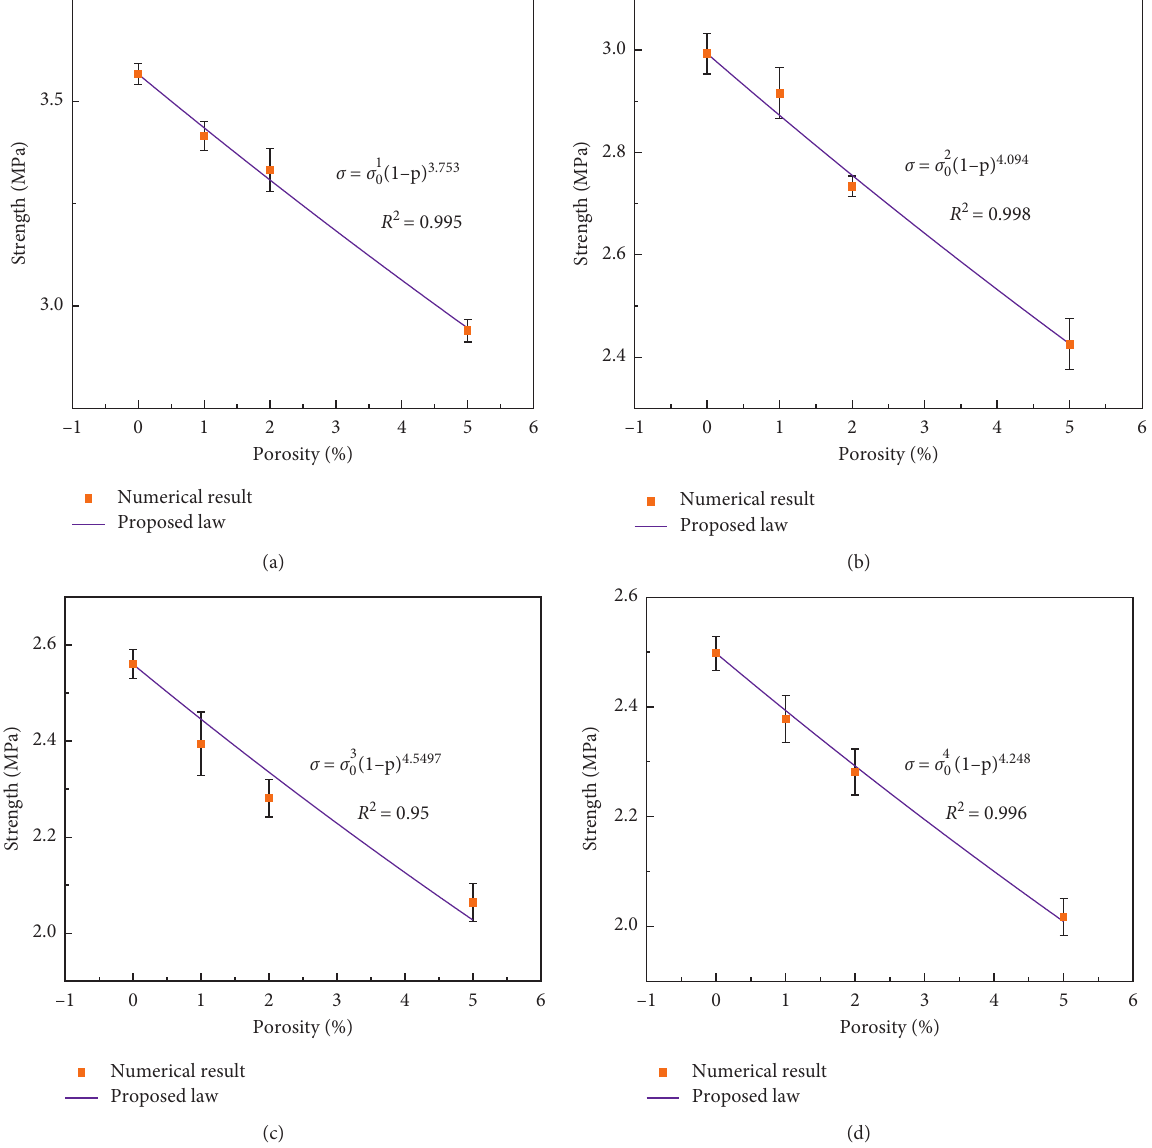
Figure 14: Effect of porosity on strength for models with different rubber contents ( P content � 5%. (c) Rubber content � 10%. (d) Rubber content �